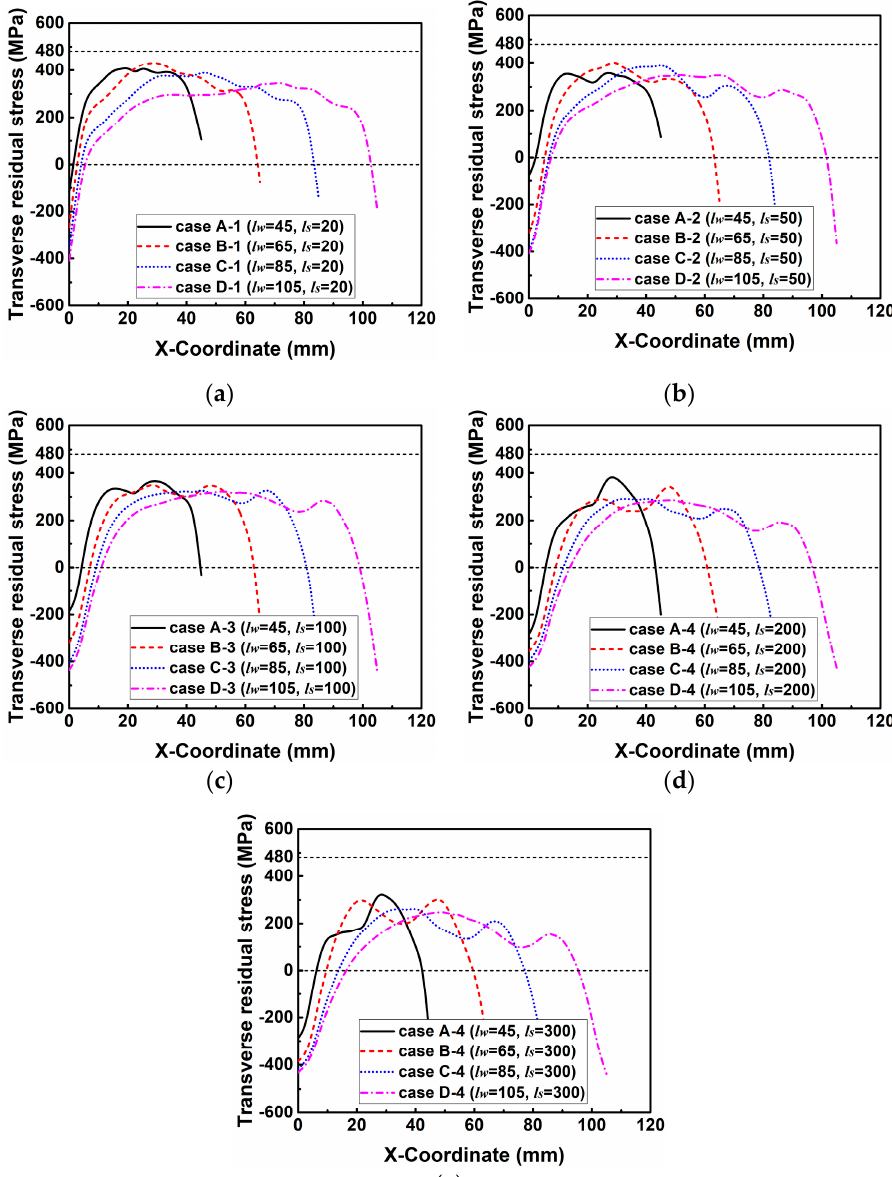
Figure 21. Transverse residual stress distributions along line 2 in the cases of each group with varied weld length ( l w ) while the slit length ( l s ) is kept constant: ( a ) Group 1; ( b ) group 2; ( c ) group 3; ( d ) group 4; ( e ) group 5.